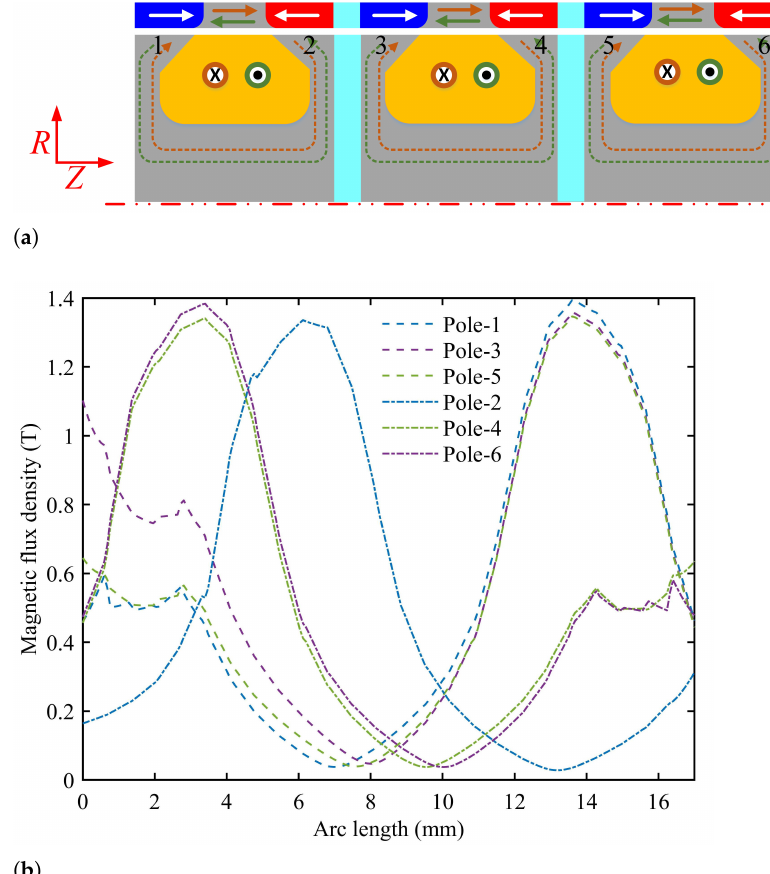
Figure 10. ( a ) Pole numbering; and ( b ) magnetic flux density in the air